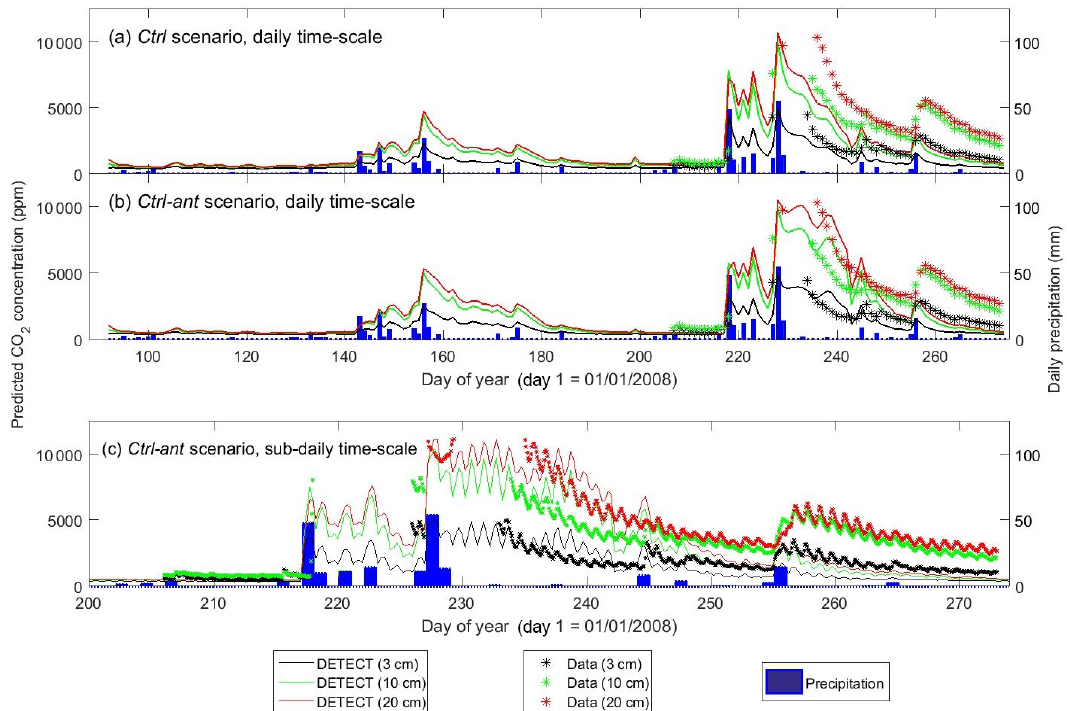
Figure 5. Time series of predicted versus observed soil CO 2 concentrations at 3cm depth, 10cm depth, and 20cm depth, where the pre- dictions are based on the non-steady-state (NSS) DETECT model. Predicted [CO 2 ] is shown for the daily time scale for the control scenar- ios (a) without (Ctrl) and (b) with (Ctrl-ant) antecedent effects, and for (c) the subdaily (every 6h) time scale for the Ctrl-ant scenario. Units are in parts per million